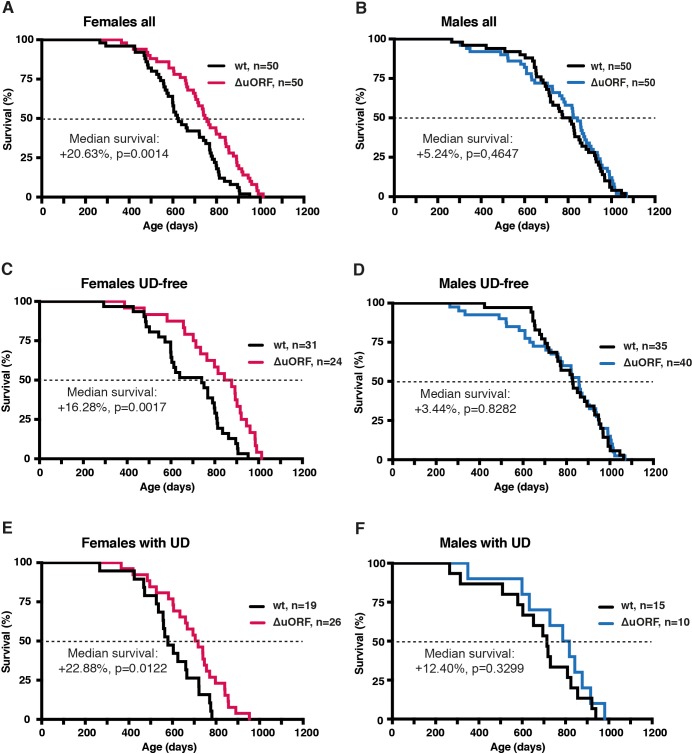
Increased survival of female C/EBPβΔuORF mice.Survival curves of (A) the complete female cohorts, (B) complete male cohorts, (C) the UD-free female cohorts, (D) UD-free male cohorts, (E) female mice with UD and (F) male mice with UD with the survival curves of wt or C/EBPβΔuORF mice indicated. The increase in median survival (%) of C/EBPβΔuORF compared to wt littermates and statistical significance of the increase in the overall survival as determined by the log-rank test is indicated in the figure.